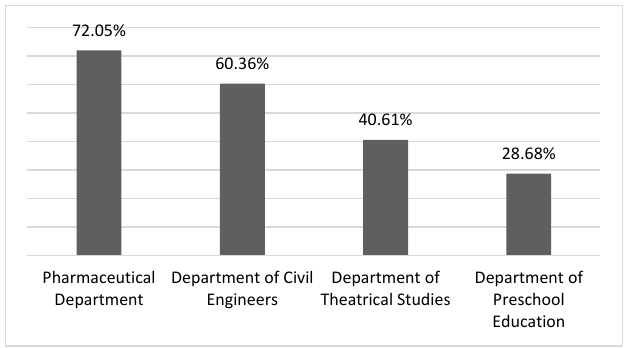
Figure 4. Percentage of students with a mother who is a higher education graduate or has postgraduate studies by university department (University of Patras).